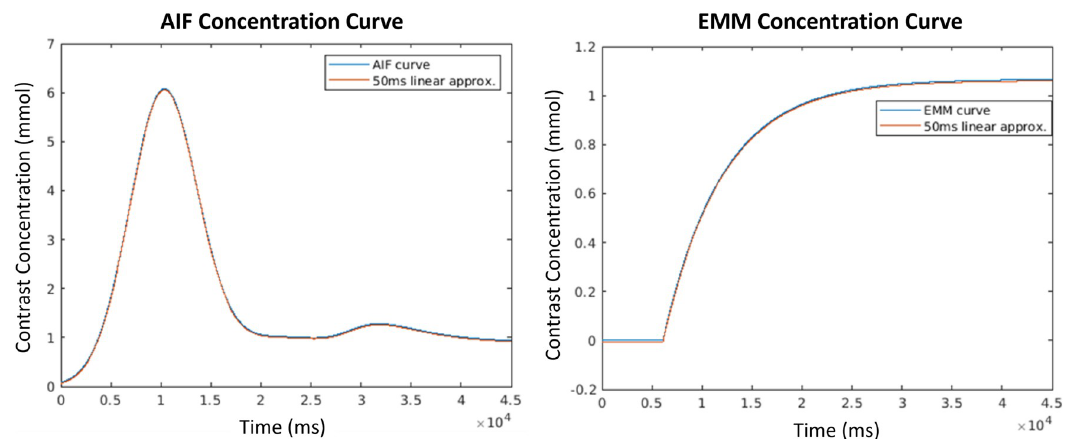
Fig 2. Sample concentration curves paired with their 50ms-interval linear approximations. The AIF curve (used in vessels) is shown on the left and the EMM curve (used in lesion voxels) is shown on the right. each k -space point across five (5) pre-contrast ultrafast images for each phantom. Each point’s